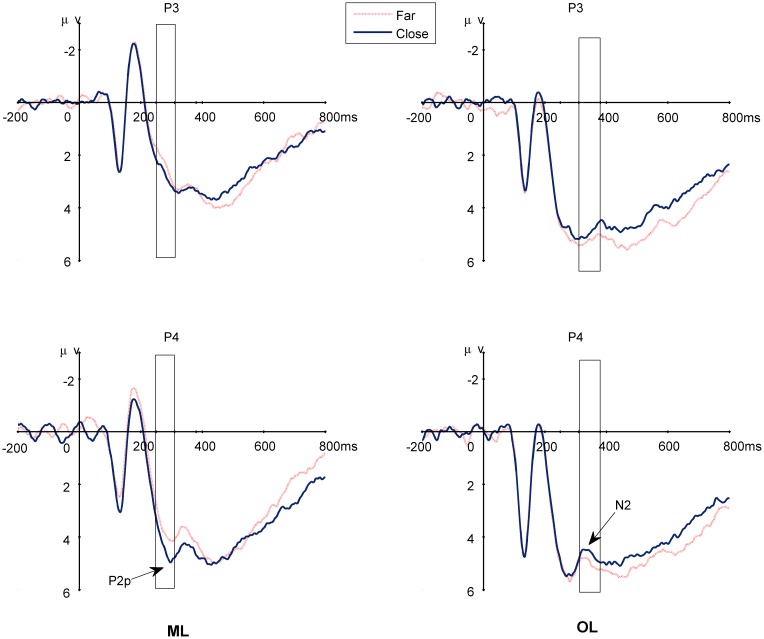
The grand average ERPs elicited by far- and close-distance pairs in Session 3.The rectangles indicate the time windows analyzed. The distance effect in the ML group appeared earlier on P2p, but later on N2 for the OL group. The pattern of the distance effect was opposite between the two groups. ML: magnitude learning; OL: order learning.